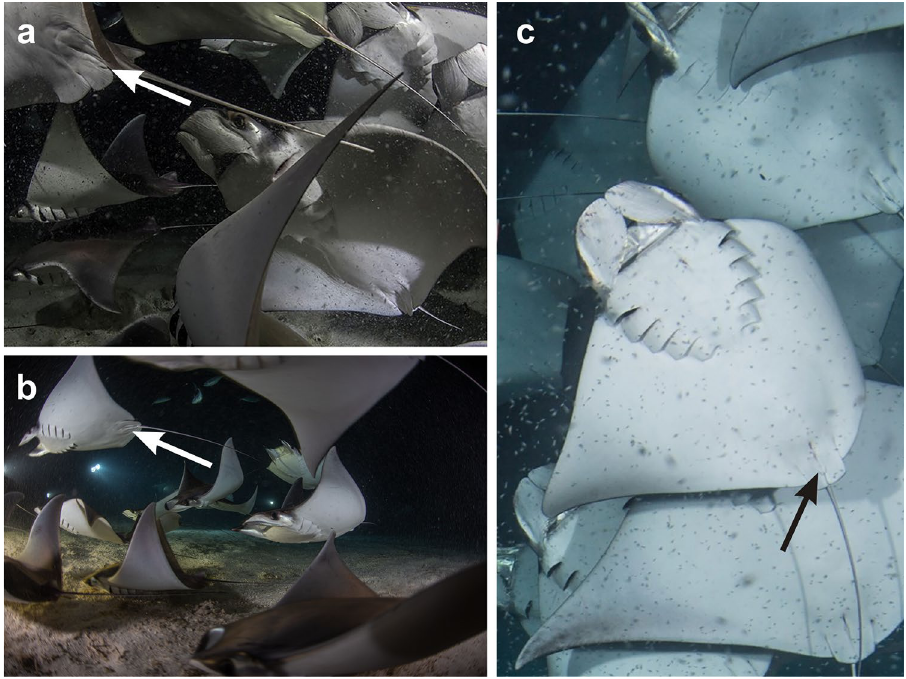
Figure 6. Juvenile males M. munkiana with undeveloped claspers (indicated by arrows) at Ensenada Grande during recreational dives in ( a ) November 2013, ( b ) October 2014 and ( c ) October 2016. Images copyright: ( a ), ( b ) Erick Higuera and ( c ) Luke